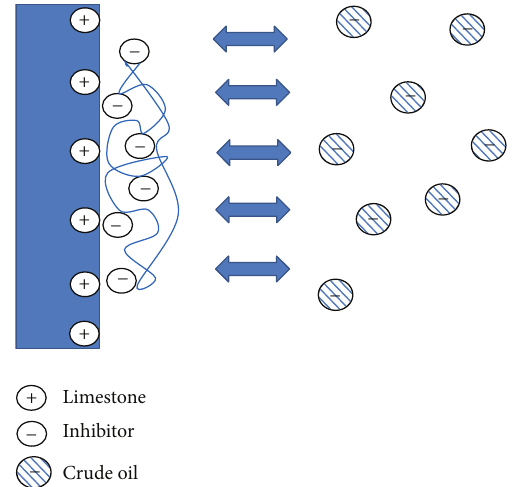
Figure 6: Mechanism of inhibitor adsorbing on the limestone sur- face in the presence of crude